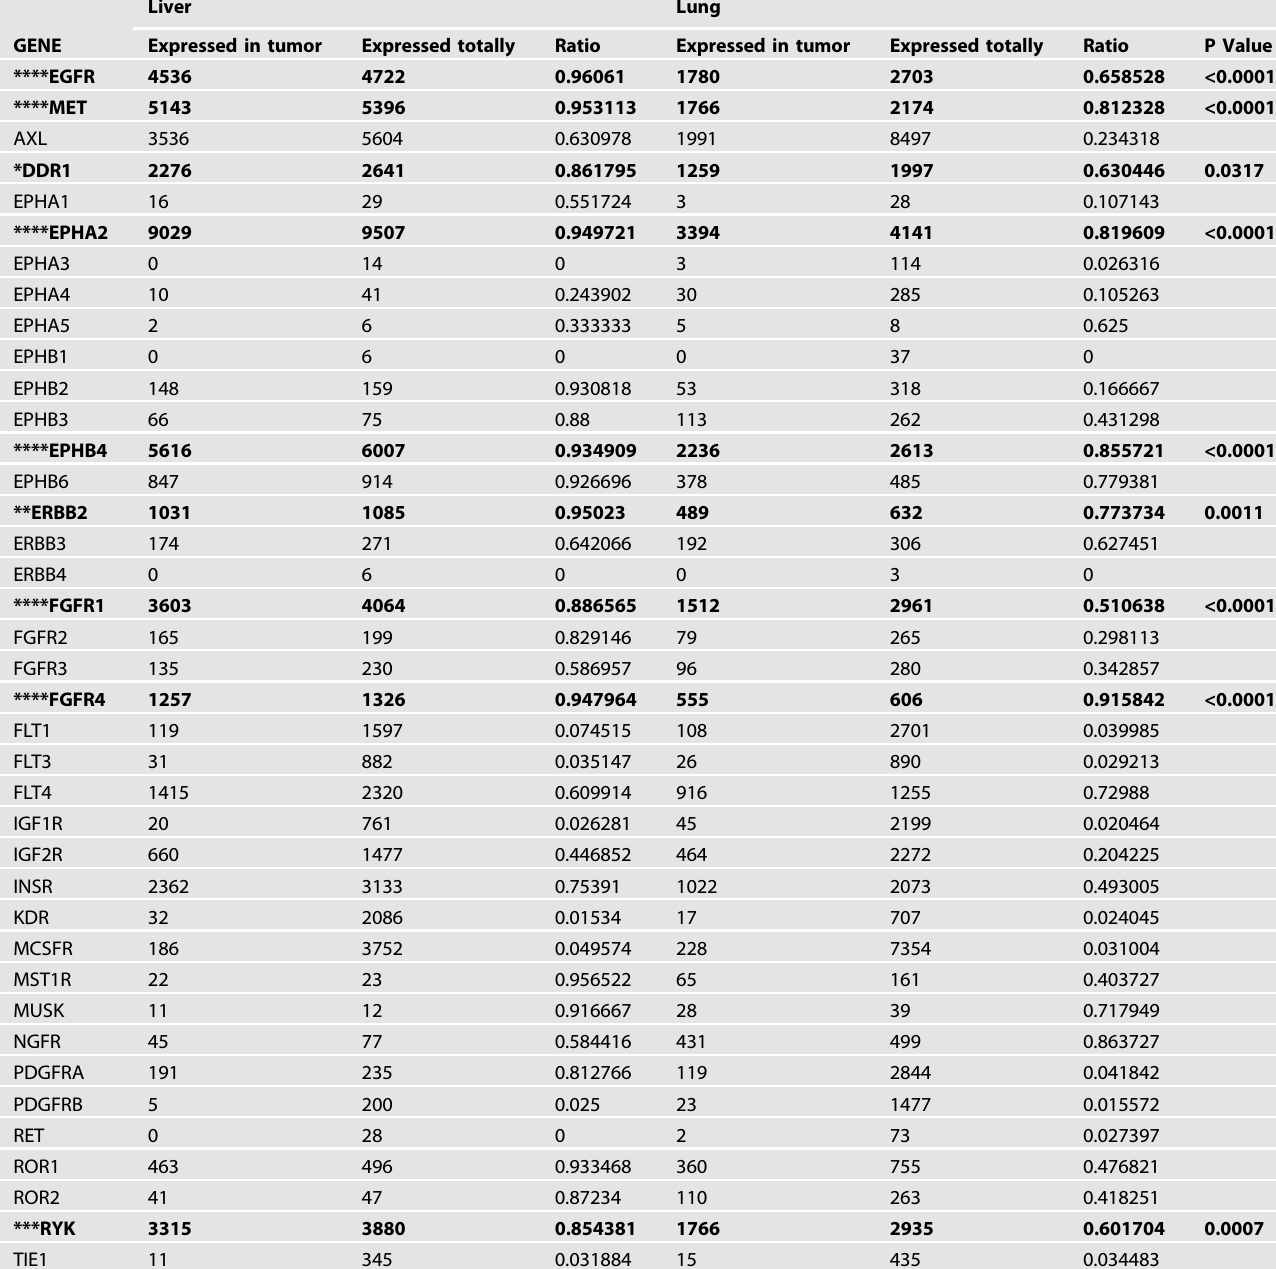
Table 1. Expression of RTKs in carcinoma